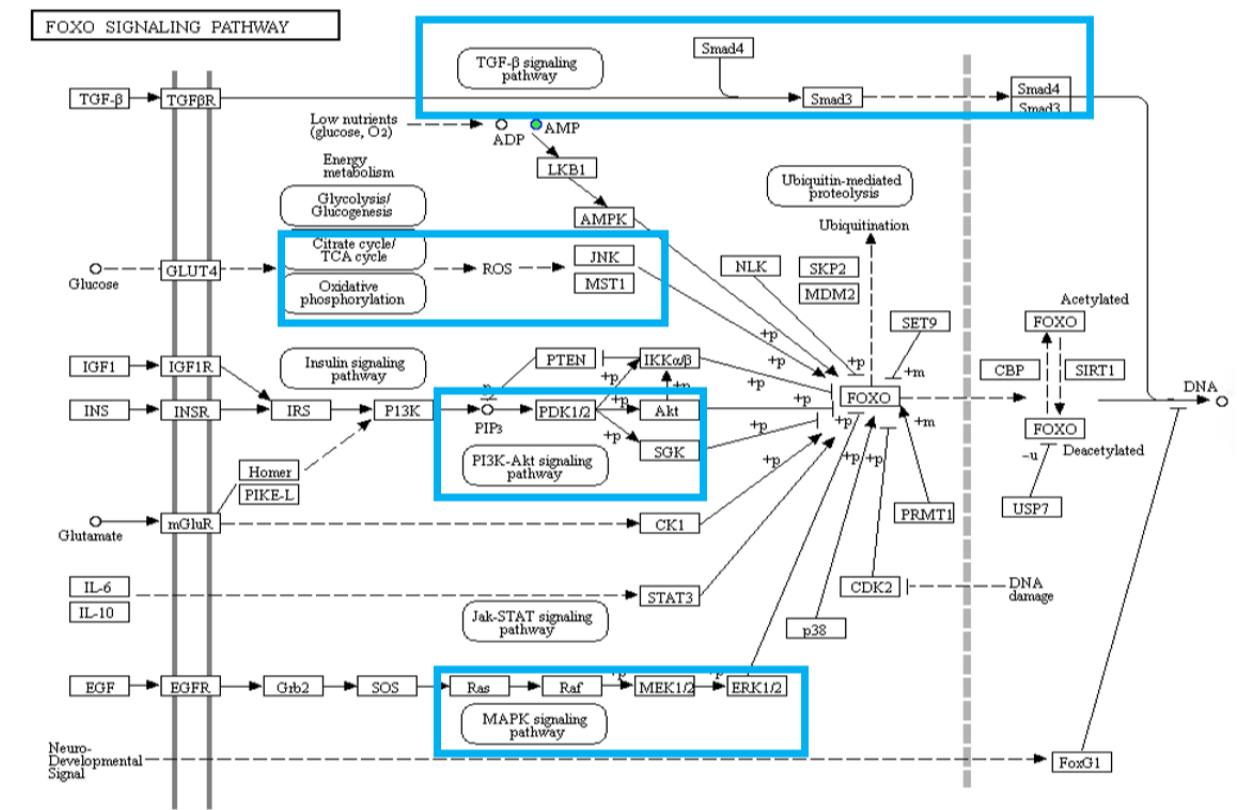
Figure 5. Schematic showing the FoxO signaling pathway under hypoxic stress. The main processes affected by hypoxia are boxed in blue.